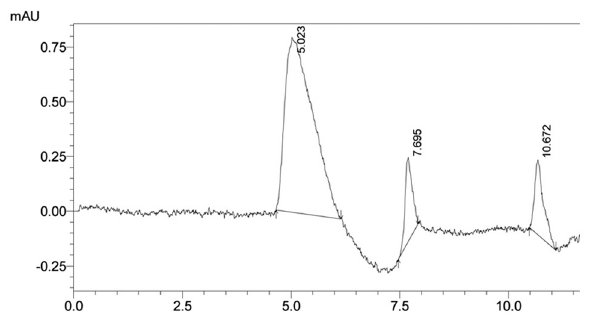
Figure-2: Retention time of aflatoxin B in the feed matrix after solid phase extraction column separation from impurities (5.023 and 7.695 min). The α of the first impurity was 2.125 (ratio, numerator 10.672 min to denominator 5.023 min). The α of the second impurity was 1.387 (ratio numerator 10.672 min to denominator 7.695